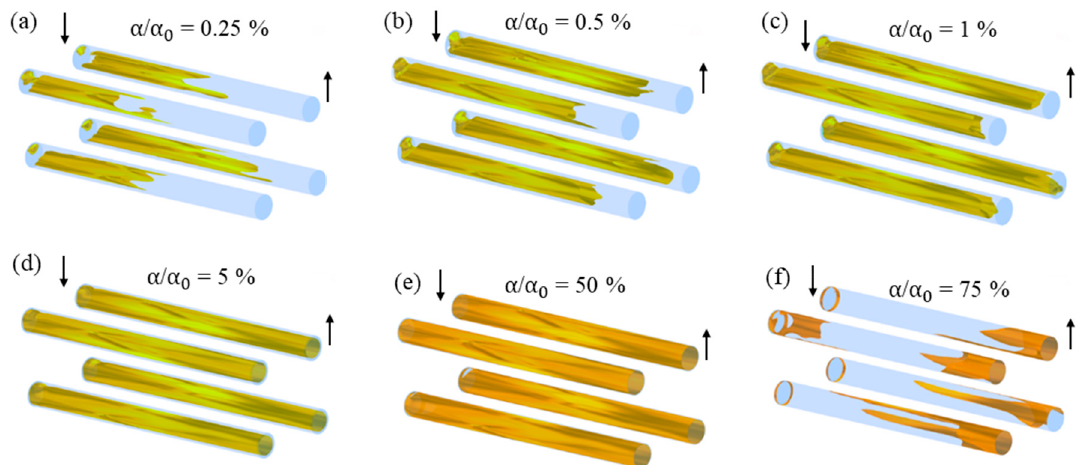
Figure 10. Iso-surfaces of the relative oil volumetric fraction in different regions of the permeated in the filtration module during the water / oil separation process: ( a ) α / α 0 = 0.25%; ( b ) α / α 0 = 0.5%; ( c ) α / α 0 = 1%; ( d ) α / α 0 = 5%; ( e ) α / α 0 = 50% and ( f ) α / α 0 =